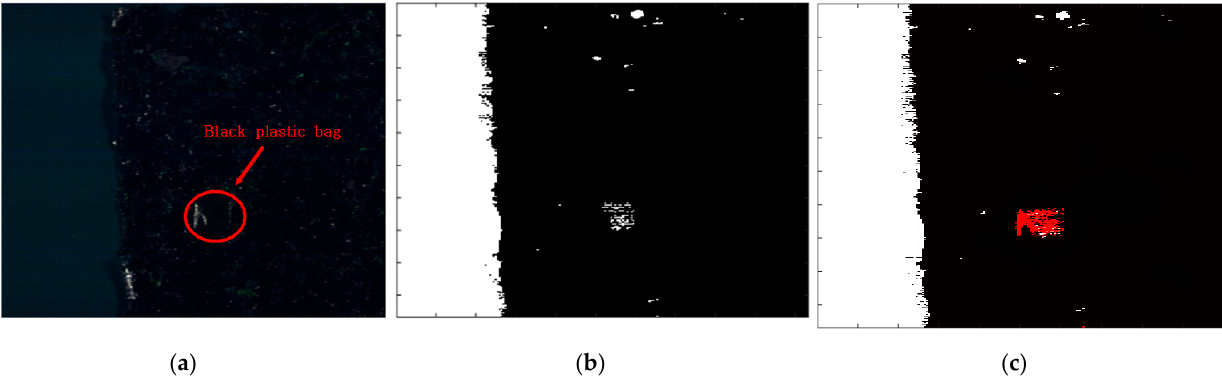
Figure 9. Results of each inspection step. ( a ) Raw hyperspectral image, ( b ) After applying the subtraction method ( c ) After applying the standardization inspection.